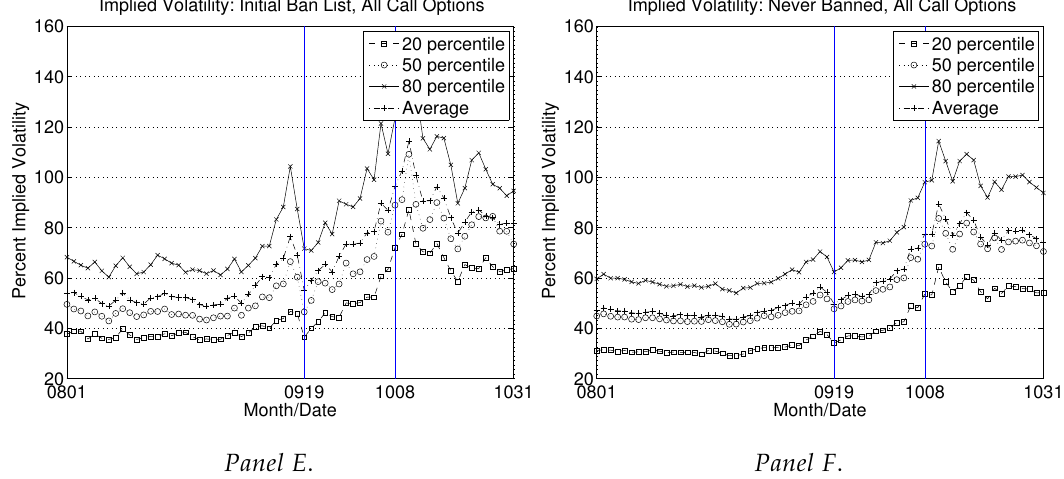
Panel F . Figure 1. Time series of cross sectional options summary statistics. All call options of Initial Ban List and Never Banned Stocks during the ban and non-ban periods: ( A , C , E ) results for the three variables for Initial Ban List Stocks; and ( B , D , F ) results for the three variables for Never Banned